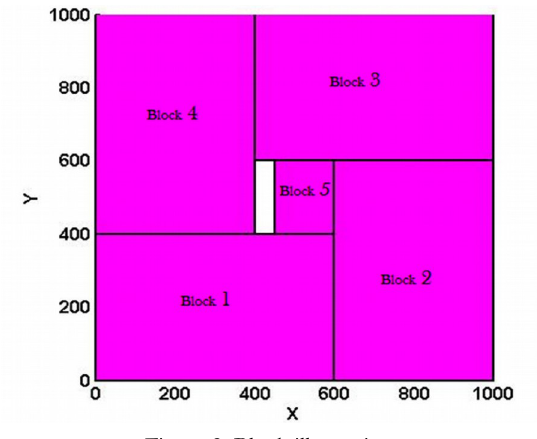
Figure 2. Block illustration